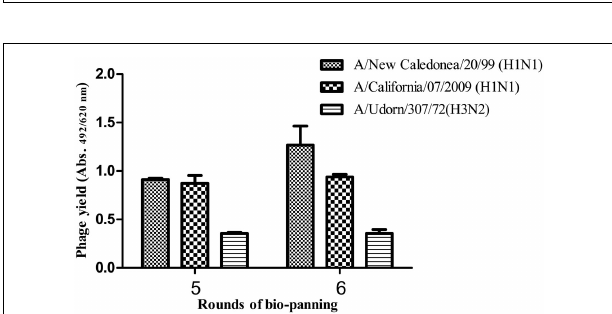
FIGURE 4 | Affinity selection of phage-bound anti-HA scFv antibodies from the antibody library . A considerable rise in the specific scFv antibodies was observed after the sixth round of bio-panning against the A/New Caledonia/20/99(H1N1) virus.